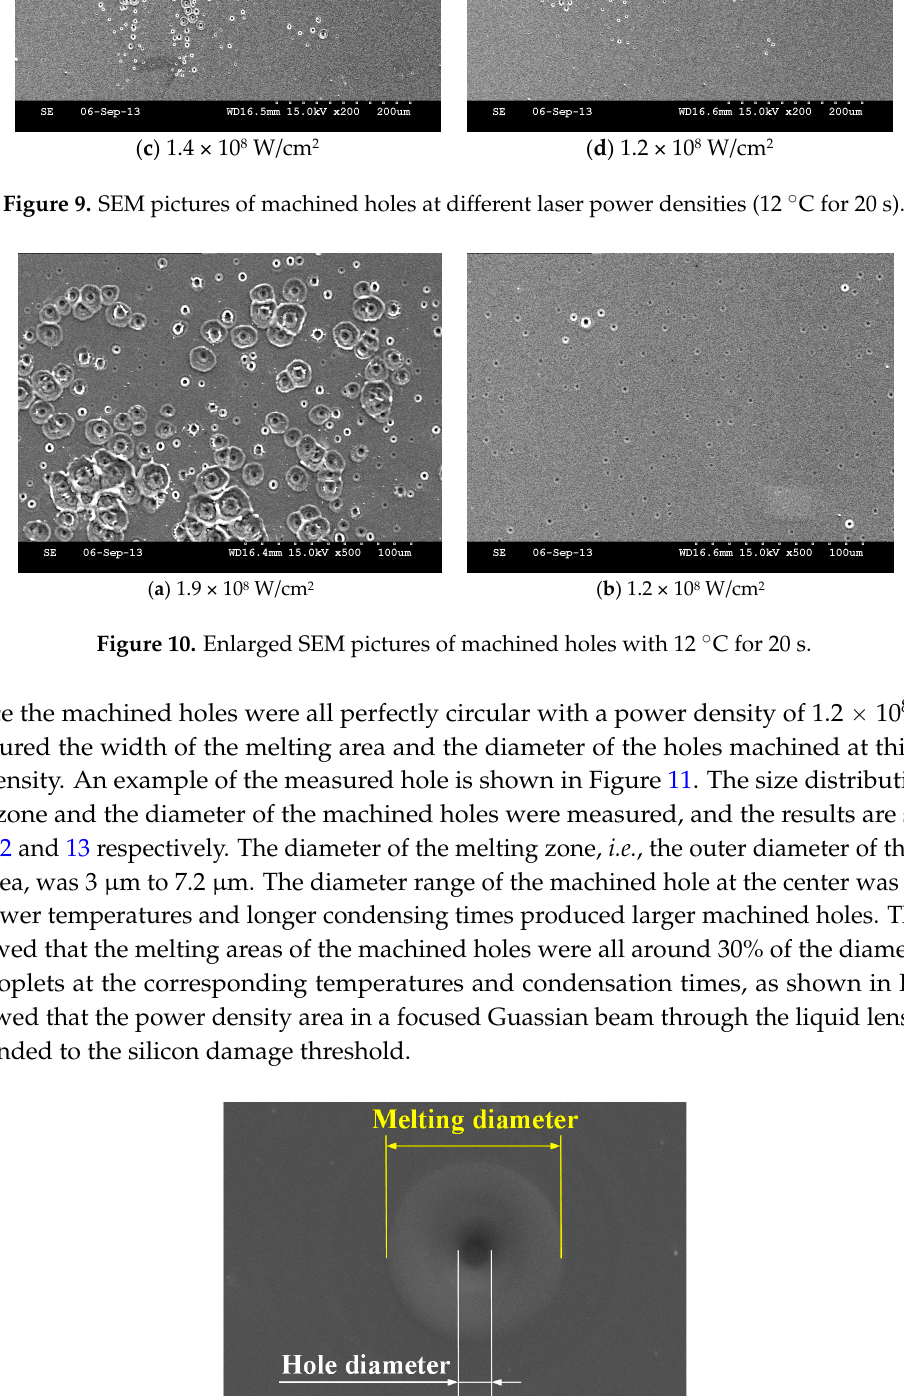
Figure 11. SEM picture of a machined hole with power density of 1.2 10 8 W/cm 2 at 12 ∘ C for 20 s.